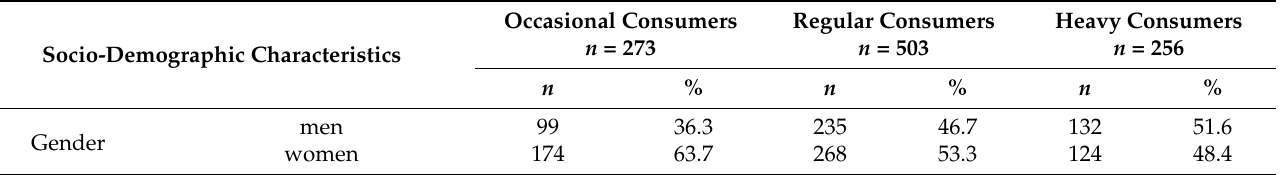
Table 2. Socio-demographic characteristics of individual segments of edible mushrooms